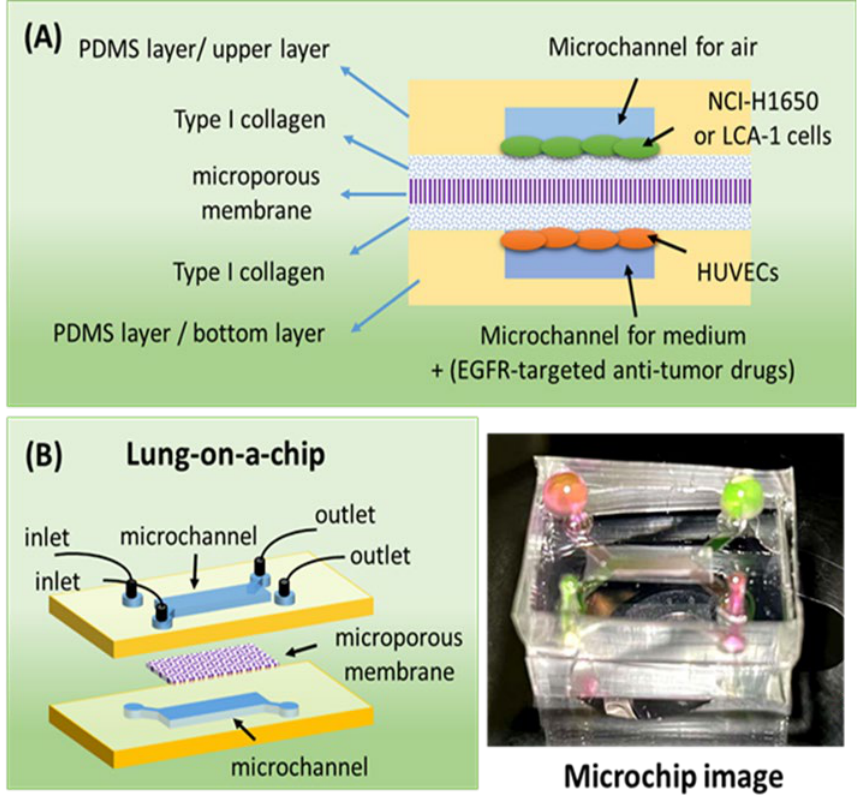
Figure 1. ( A ) A schematic diagram of the experimental principle. ( B ) A schematic diagram and image of the